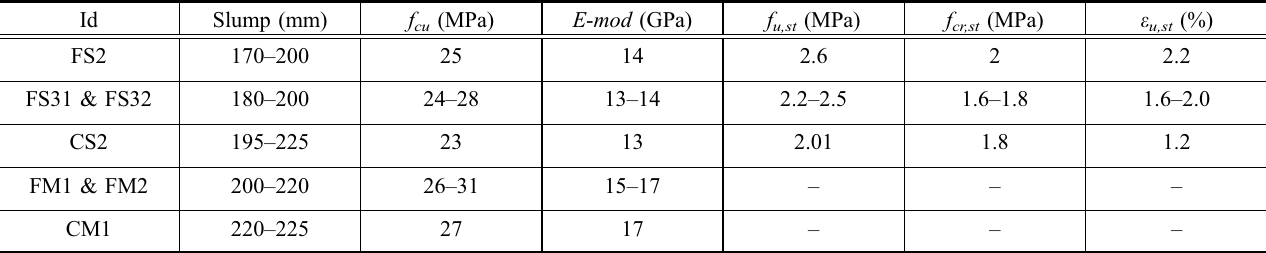
Table 3 SHCC and mortar fresh and mechanical